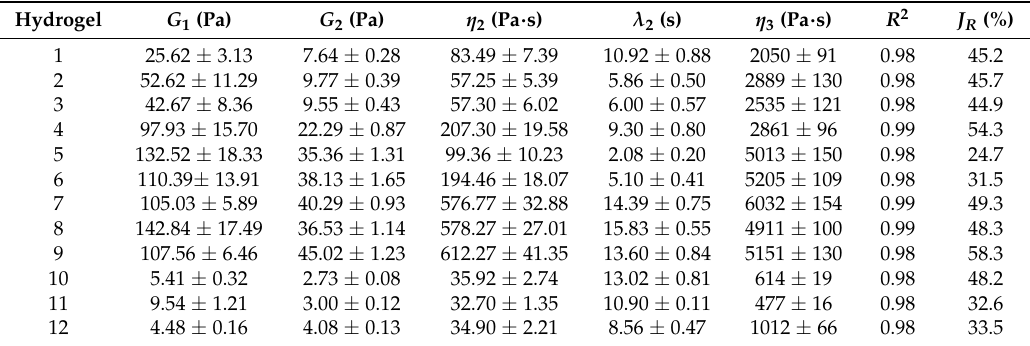
Table 2. Best-fitting parameters calculated for the creep curves and obtained for each hydrogel, according to Equation (2). The last column reports the percentage recovery of